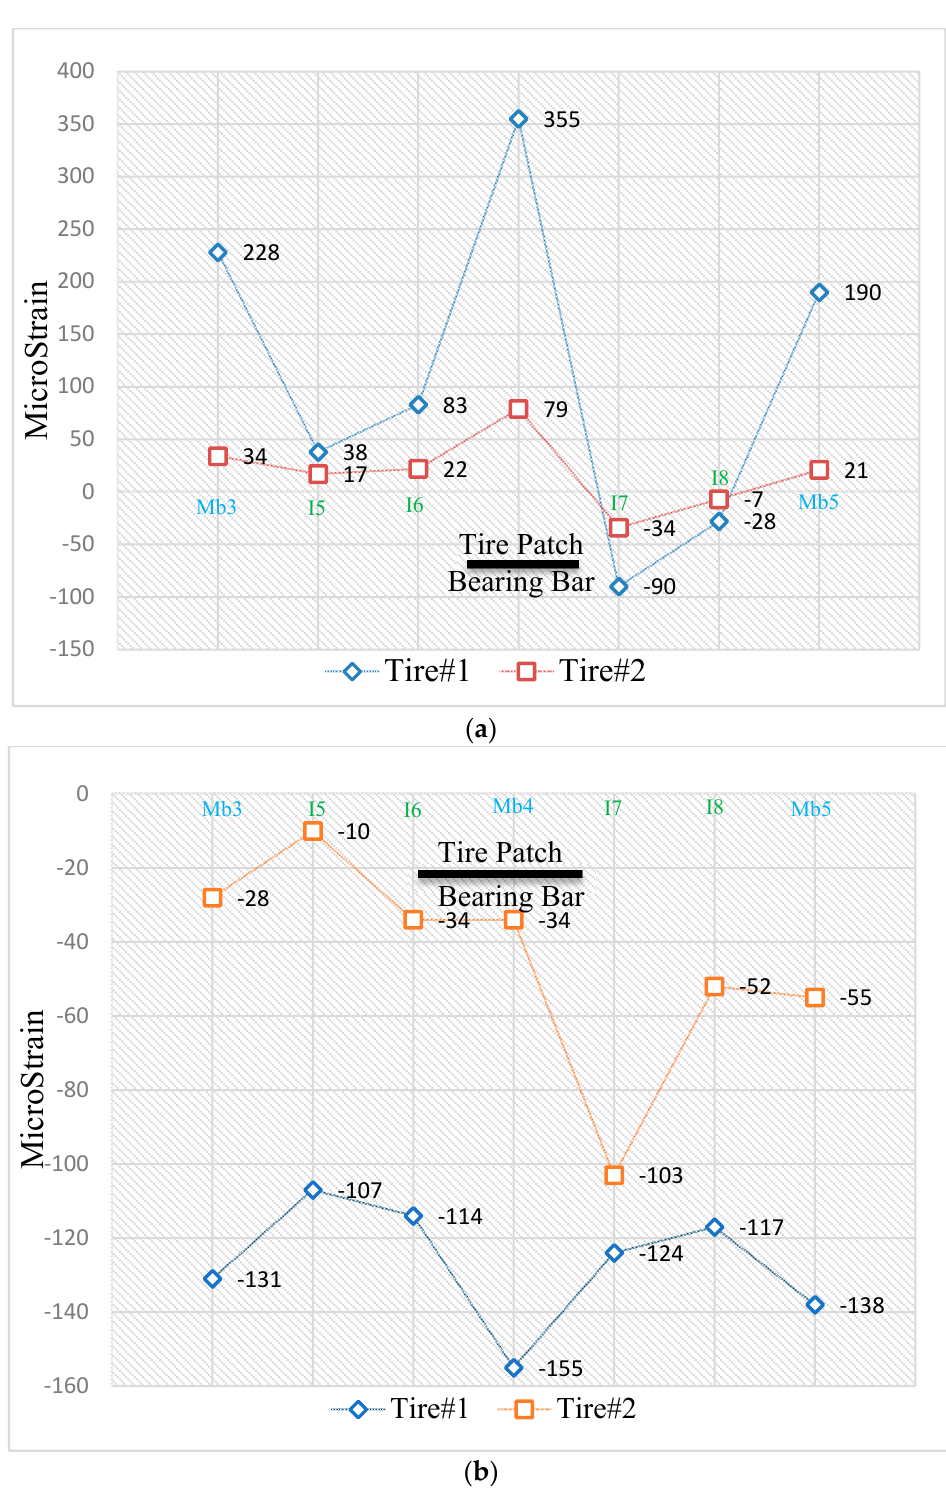
Figure 9. Strain distribution along the width in ( a ) tension ( b ) compression.